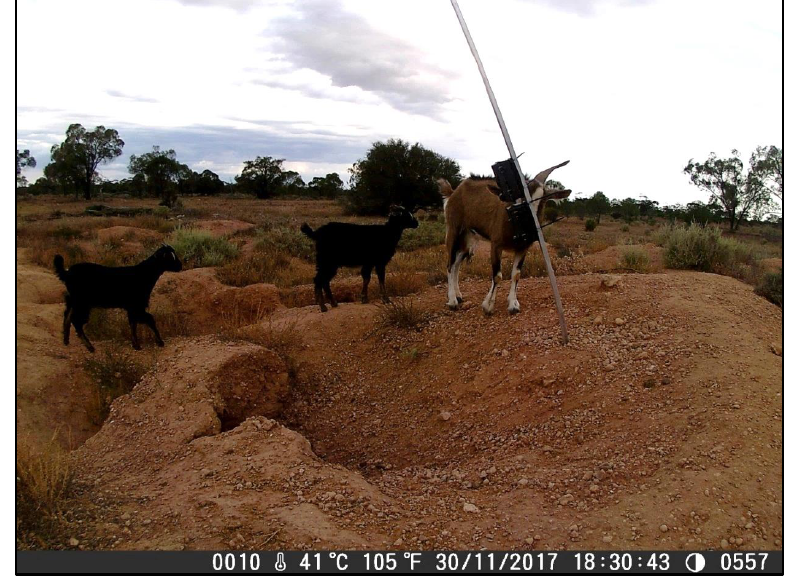
Figure 7. Feral goats examining one of our camera poles in Brookfield Conservation Park (site #1). The close-up cameras are visible in the image, which was captured on the medium-range camera.